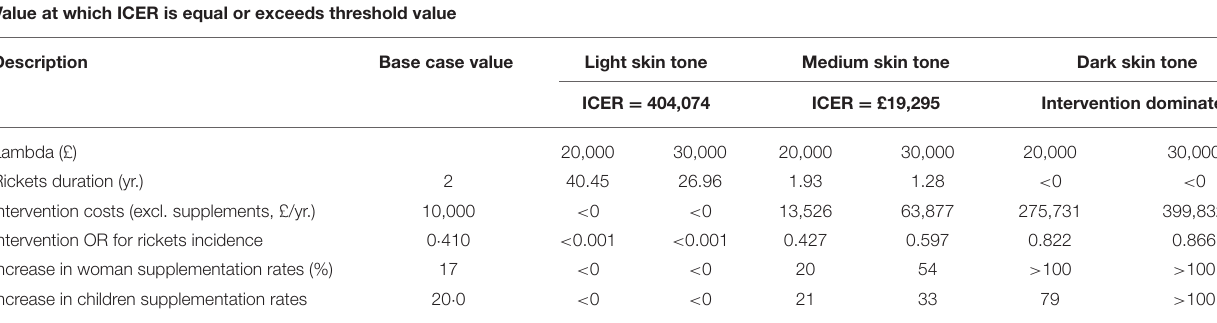
TABLE 9 | Parameter threshold analysis to determine decision changing values for most uncertain parameters.